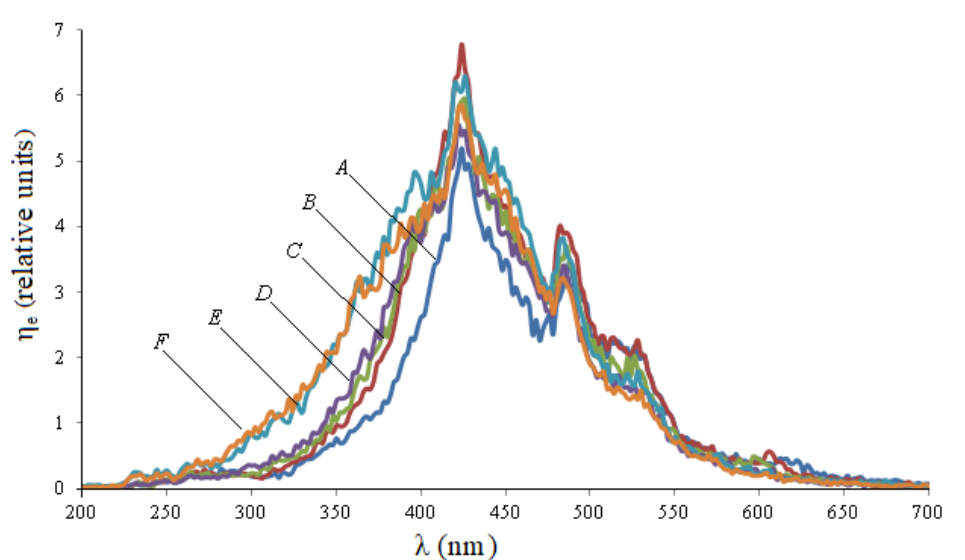
Figure 1. Excitation spectra η e ( λ ) for synchronous scanning of wheat seeds at the displacement: A — 50 nm, B — 60 nm, C — 70 nm, D — 80 nm, E — 90 nm, F — 100 nm. Table 1. Integral parameters of the excitation spectra of wheat seeds.